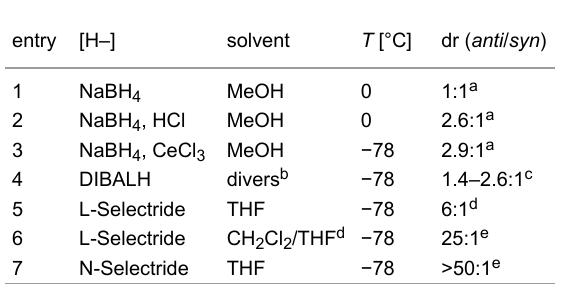
Table 4: Diastereoselectivity in the reduction of ketone 14a